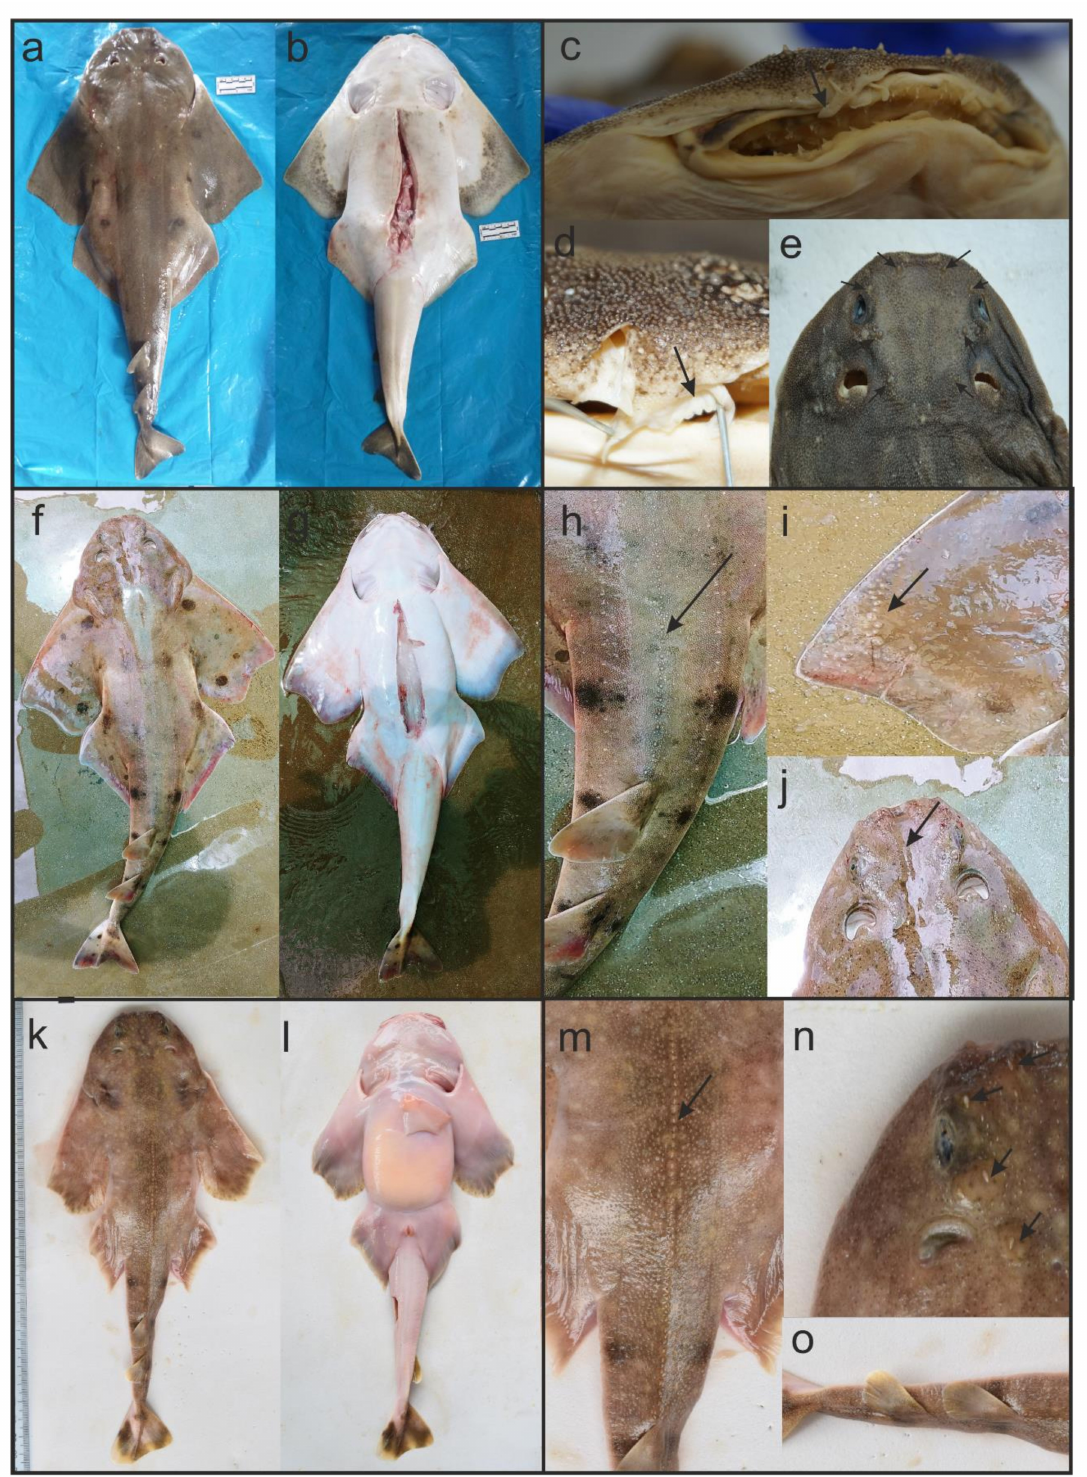
Figure 2. Specimens of angel sharks collected for this study: Dorsal ( a ) and ventral ( b ) images of one fresh specimen of Squatina armata (Pemar_V0173). Detailed images of barbels ( c ), anterior nasal flaps ( d ) and thorns on snout, between eyes and spiracles ( e ) observed on preserved specimen of S. armata (Pemar_V0174). Dorsal ( f ) and ventral ( g ) images of one fresh specimen observed on Squatina sp. (Pemar_V0209). Detailed images of thorns along the middle line of the back ( h ), denticles covering the edges of the pectoral fin ( i ) and concave between eyes ( j ) of specimens of Squatina sp. (Pemar_V0209 and Pemar_V0211). Dorsal ( k ) and ventral ( l ) images of one fresh pup of S. californica (LCT_2160). Detailed images of thorns ( m , n ) and pale dorsal fins ( o ) of S. californica pup